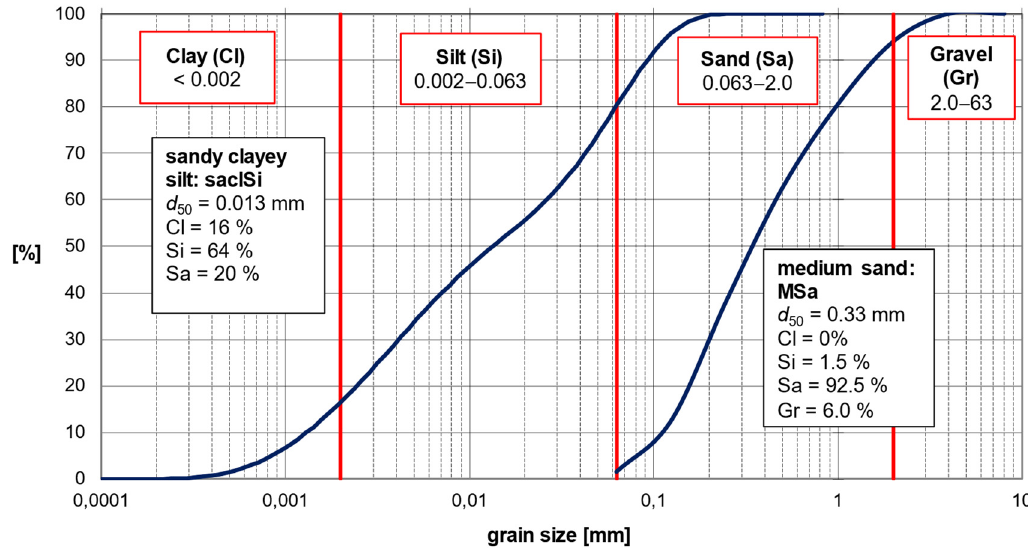
Figure 3. Grain size distribution of the tested soils.